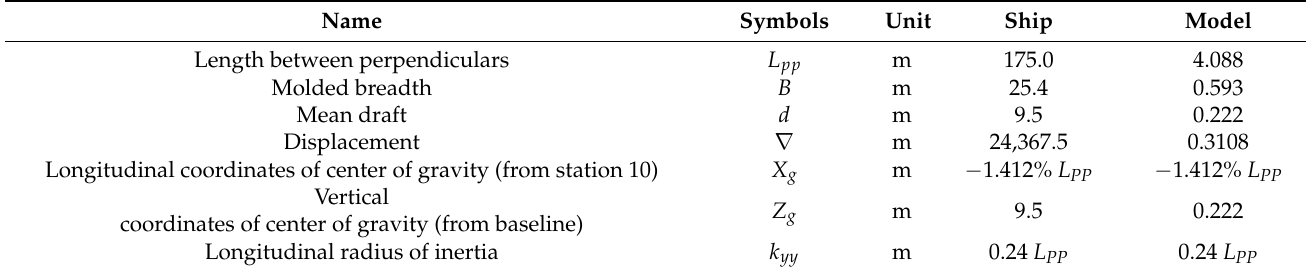
Figure 5. Open-water curve of propeller. Table 1. Hull elements ( λ = 1:42.8).